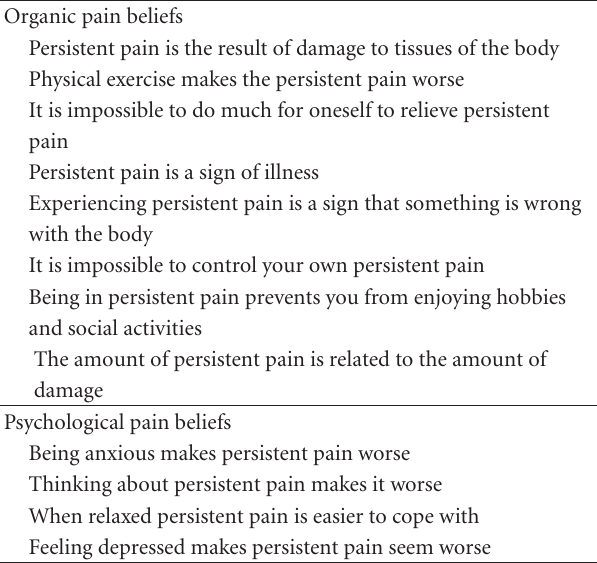
Table 1: PBQ organic and psychological pain beliefs of the PBQ. Organic pain